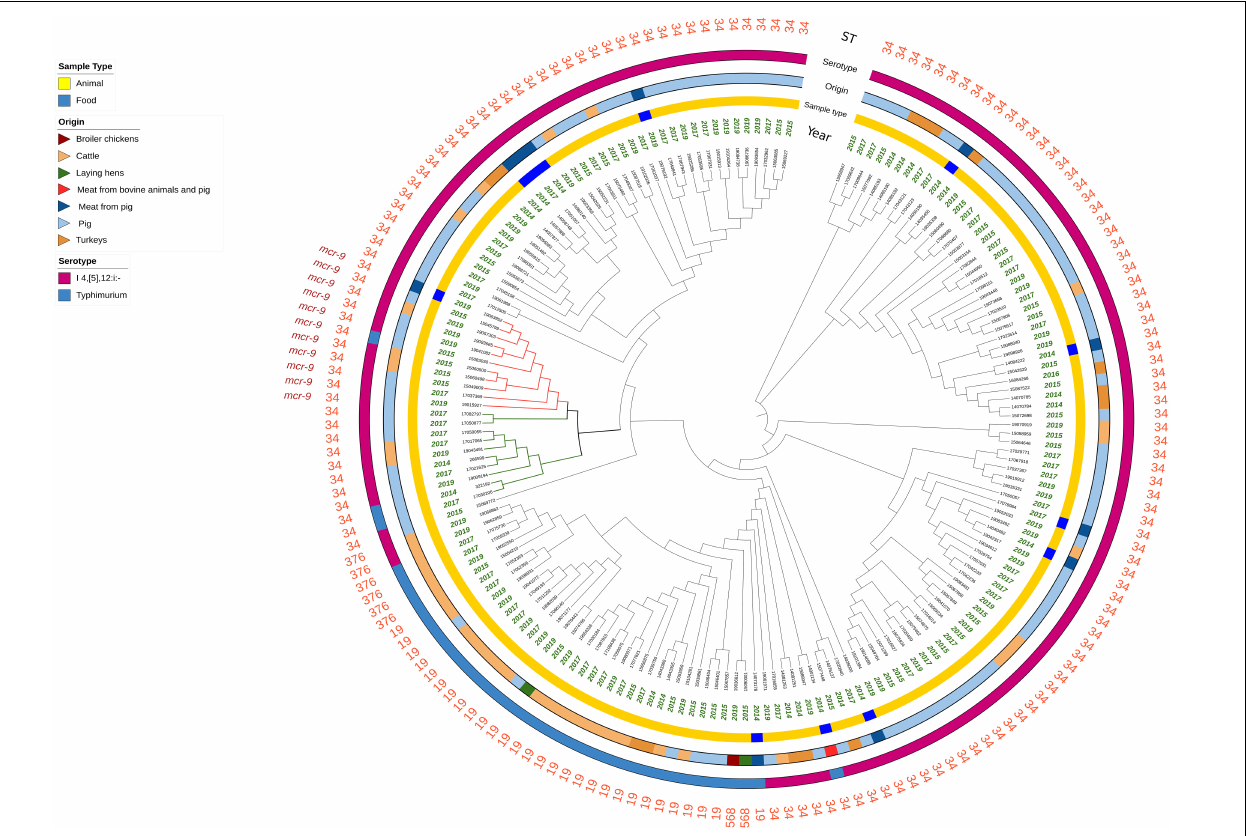
FIGURE 1 | Circular representation of the Mash analysis of the 177 Salmonella genomes analyzed. Branch length is not proportional to the genetic distance. The red branches indicate the mcr-9-positive isolates harboring IncHI2 plasmids, and the green branches indicate the mcr-9-negative isolates harboring IncHI2